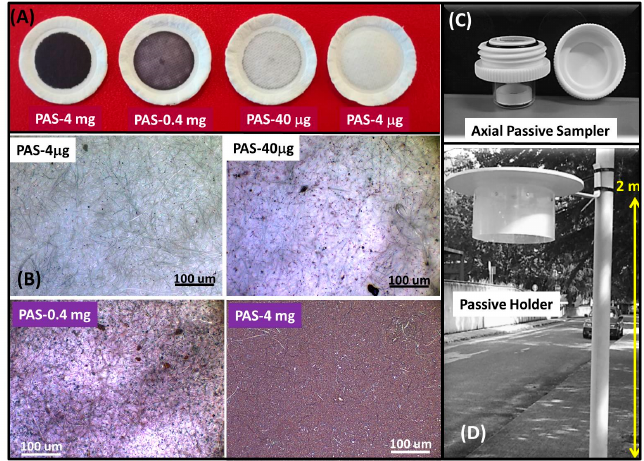
Figure 1. Composite picture ( right ) showing the quartz microfibrous filters upon Au@TiO 2 nanoparticle (NP) deposition ( A ). The different colors of the discs is related to the amount of Au@TiO 2 NPs mass ‐ loaded. Images are captured by camera ( A ) and optical microscopy ( B ). ( C ) A passive sampler architecture showing the double screw cap and the glass vessel with the polytetrafluoroethylene (PTFE) ring inside. ( D ) The global monitoring system with the customized